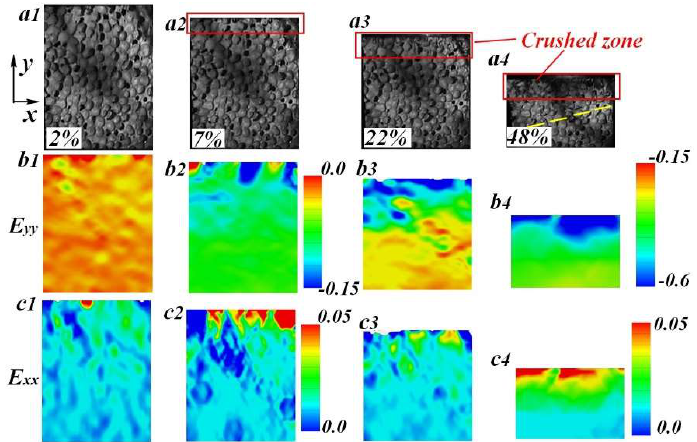
Figure 10. ( a ) Typical deformation behavior and ( b – c ) strain fields of LC specimen under drop-weight